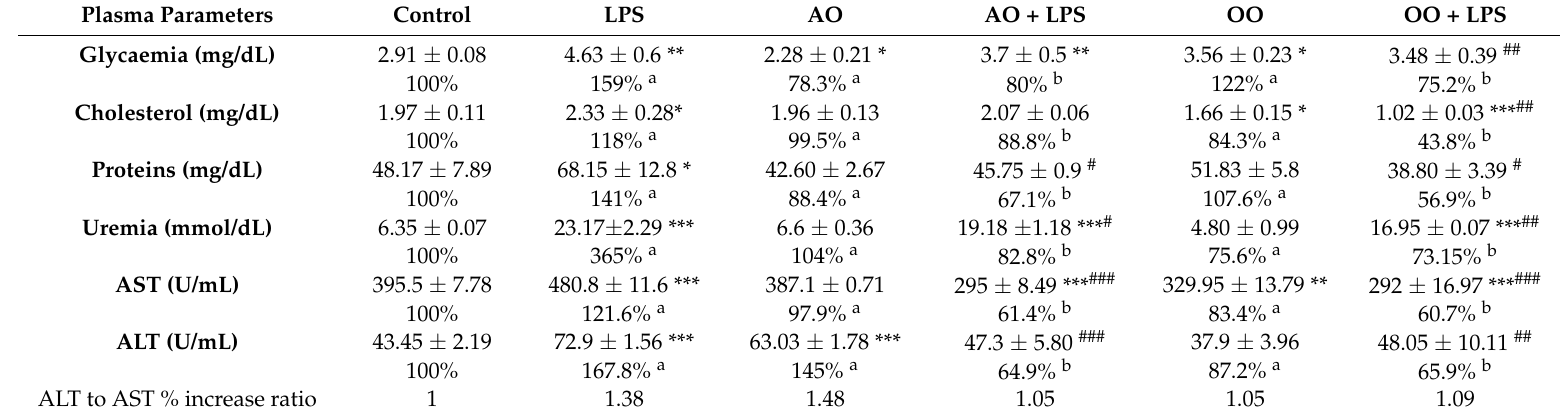
Table 1. Protective effects of argan oil (AO) and olive oil (OO) against LPS (lipopolysaccharide)-induced dysregulation, in regard to plasmatic biochemical